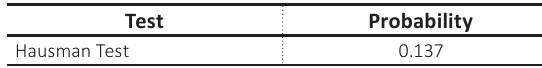
Table 7. Model specification test